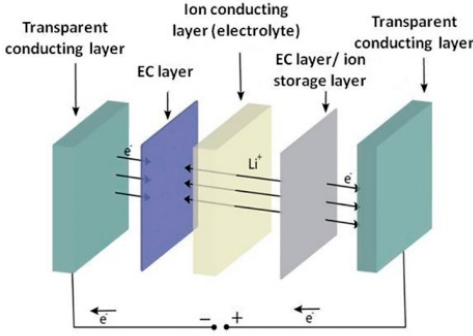
Figure 1. Typical structure of an electrochromic (EC) device.